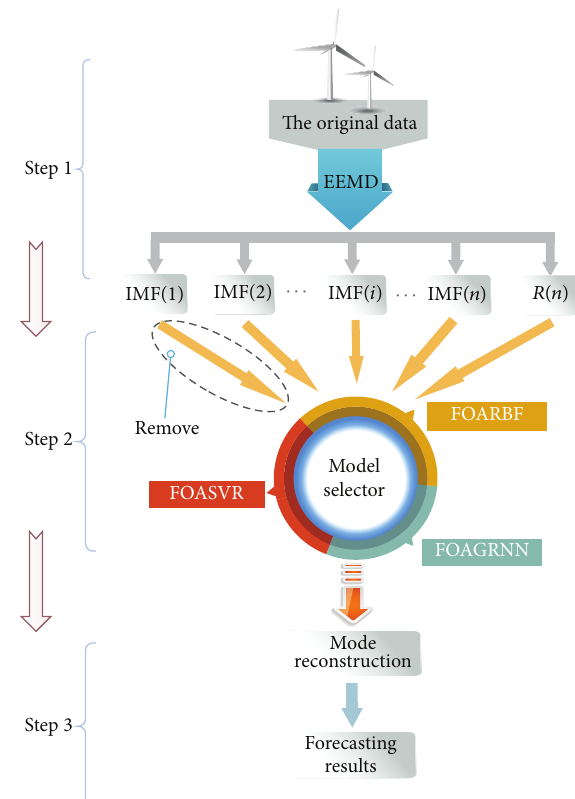
accuracy of forecasting models, as shown in Table 1. In addi- tion, two benchmark models and bias-variance framework are used to test the hybrid model.